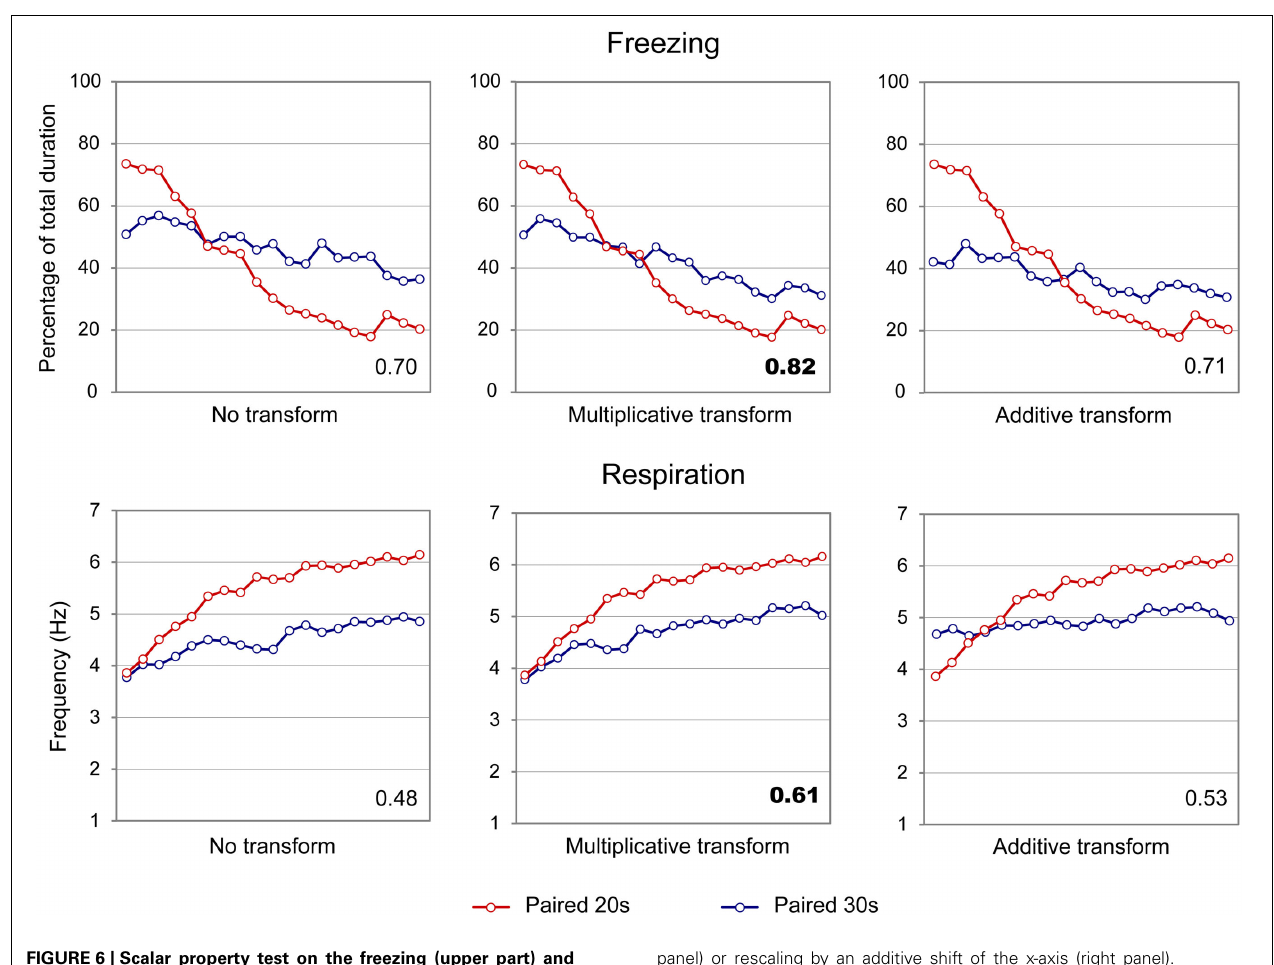
panel) or rescaling by an additive shift of the x-axis (right panel). Superposition between the two curves was indexed by eta-square ( η 2 ) indicated in the bottom right of each graph, the highest values being highlighted in bold